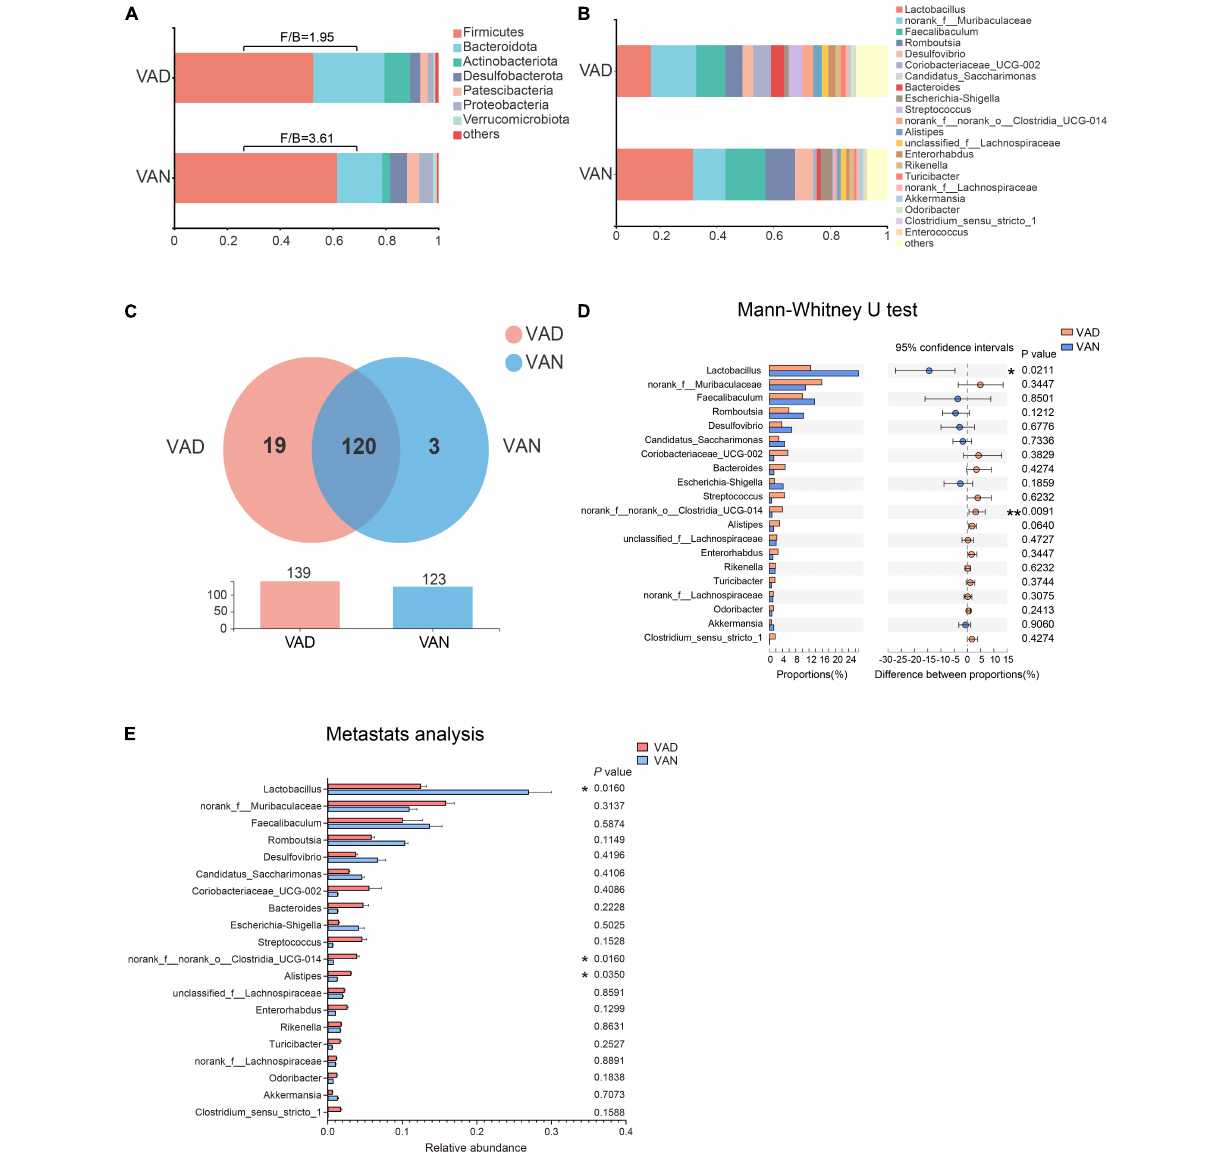
FIGURE 5 | Consumption of the VAD diet for 45 weeks altered the gut microbiota of APP/PS1 transgenic mice. (A) The fecal microbiota composition at the phylum level. (B) The fecal microbiota composition at the genus level. (C) Venn diagram illustrated the overlap and number of the genus identified in the fecal samples obtained from the VAD- and VAN-fed mice. (D) Comparison of the differences of the top 20 genera identified in the fecal samples using the Mann–Whitney U test. (E) Comparison of the differences of the top 20 genera identified in the fecal samples using Metastats analysis. F/B, the Firmicutes / Bacteroidetes ratio; VAD, vitamin A deficiency diet; VAN, vitamin A normal diet. n = 10 per group. ∗ P < 0.05 and ∗∗ P <